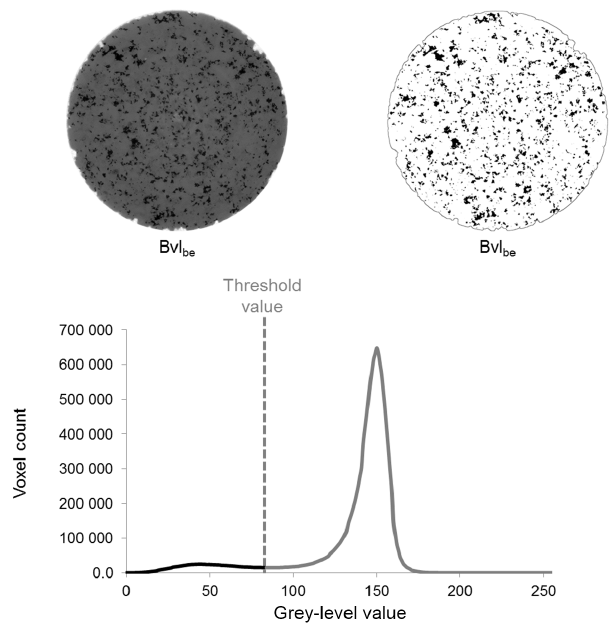
Figure 1. Histogram of grey scale values of Bvl sample images be- fore the dissolution experiment. The threshold value n is indicated in the graph. On the top, a 2-D slice of Bvl before the dissolution experiment illustrates the pore initial pore structure on the left and the binary image next to the threshold step on the